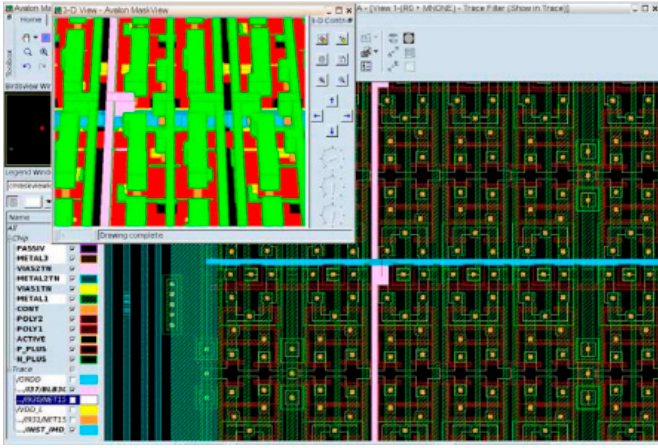
Figure 11. 3D small-area analysis to enable faster localization of circuit failures.